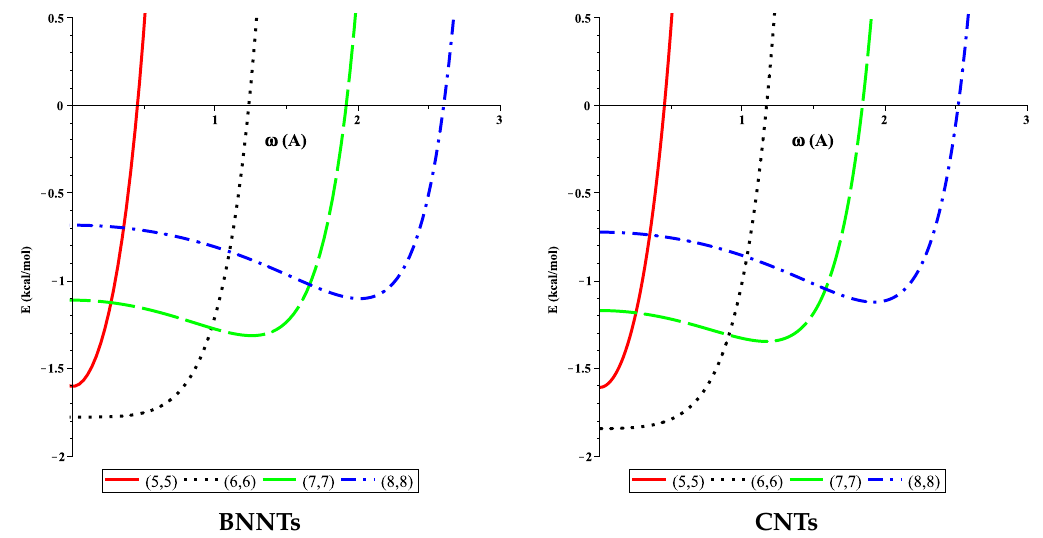
Figure 3. Interaction energies of an offset Fe atom inside BNNTs and CNTs with respect to the distance ω